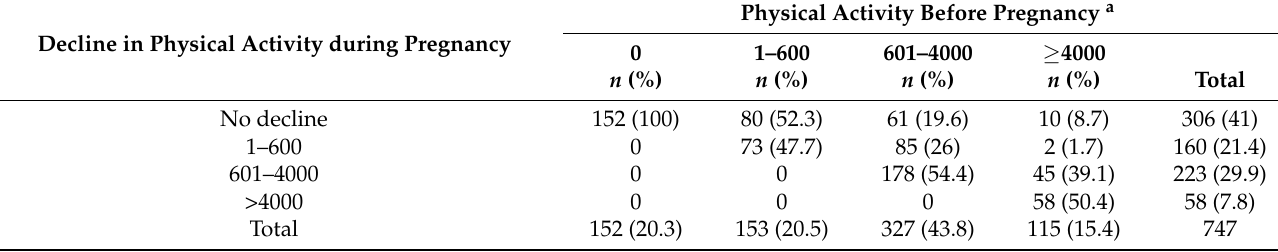
Table 3. Declines in Physical Activity from Pre-pregnancy to Pregnancy Based on Pre-Pregnancy Levels ( n = 747).